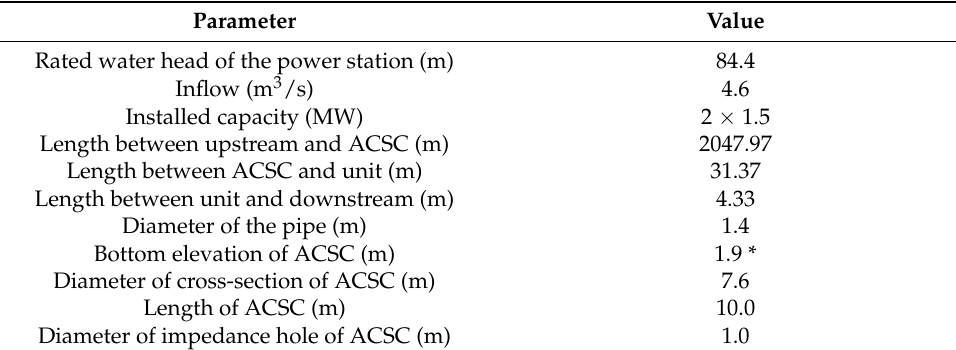
Figure 1. The pipeline system of the hydropower station with an ACSC. Table 1. Basic parameters of the studied hydropower station.